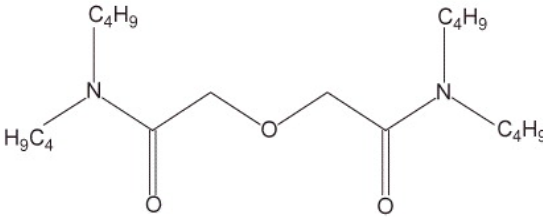
Figure 1. The chemical structure of N,N,N’,N’ ‐ tetrabutyl diglycolamide.